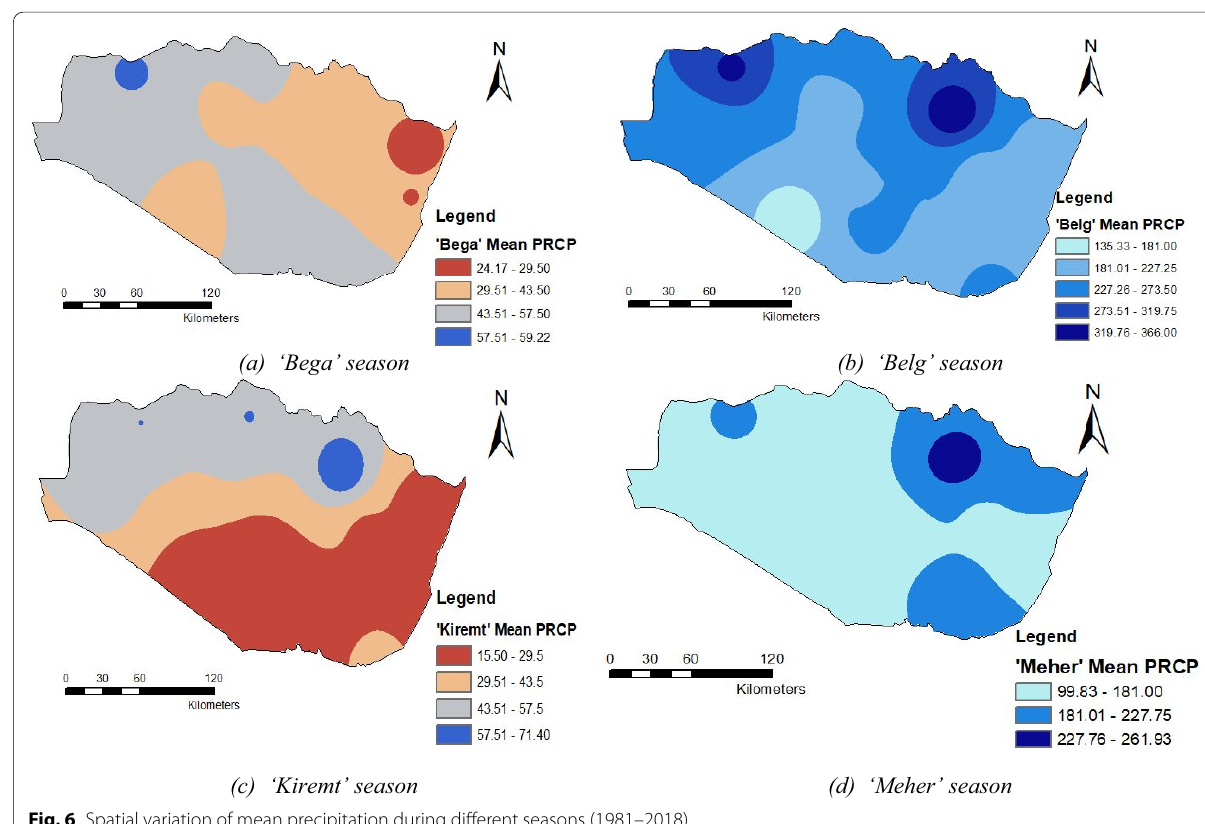
Fig. 6 Spatial variation of mean precipitation during different seasons (1981–2018)